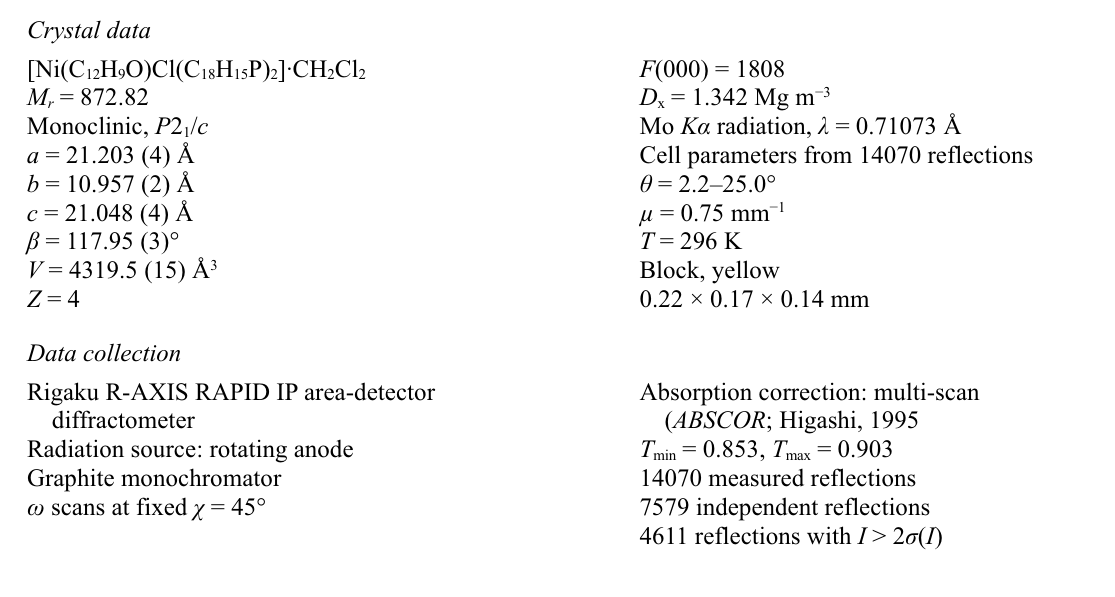
Figure 1 A view of the complex, Ellipsoids are drawn at the 30% probability level. trans -(4-Acetylnaphthyl)chloridobis(triphenylphosphine- κ P)nickel(II) dichloromethane